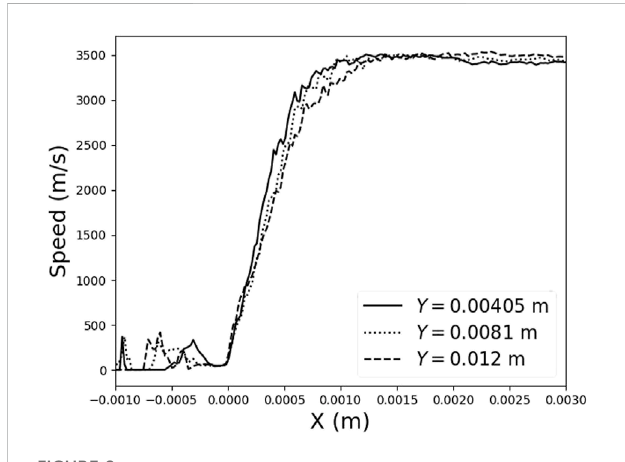
FIGURE 8 Boundary layer thickness at t = 7.5 × 10 – 6 s of Case